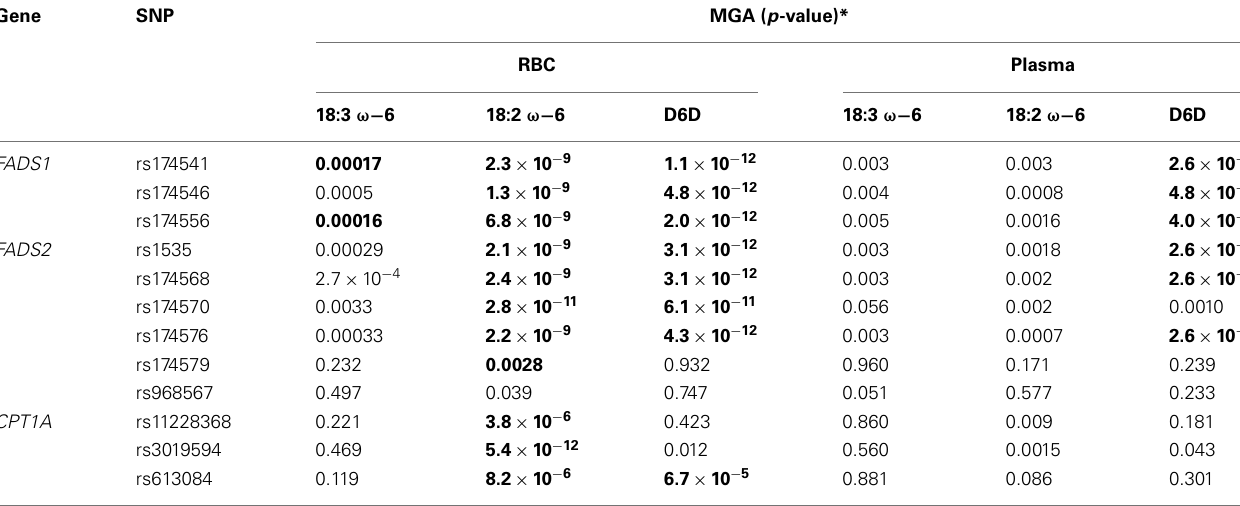
Table 3 | Measured genotype association results for SNPs with